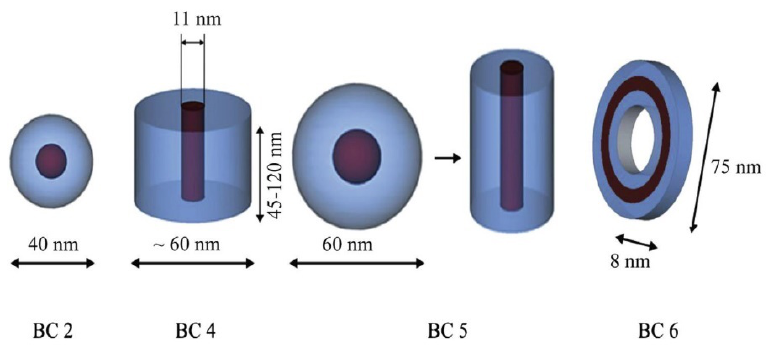
Figure 7. The increase in the POSS block fraction in the block copolymer (BC) BC2 (1 mol% POSS) < BC5 (4 mol% POSS) < BC4 (9 mol% POSS) < BC6 (11.65 mol% POSS) series leads to different morphologies. Reprinted with permission from [109]. Copyright (2014) Elsevier.